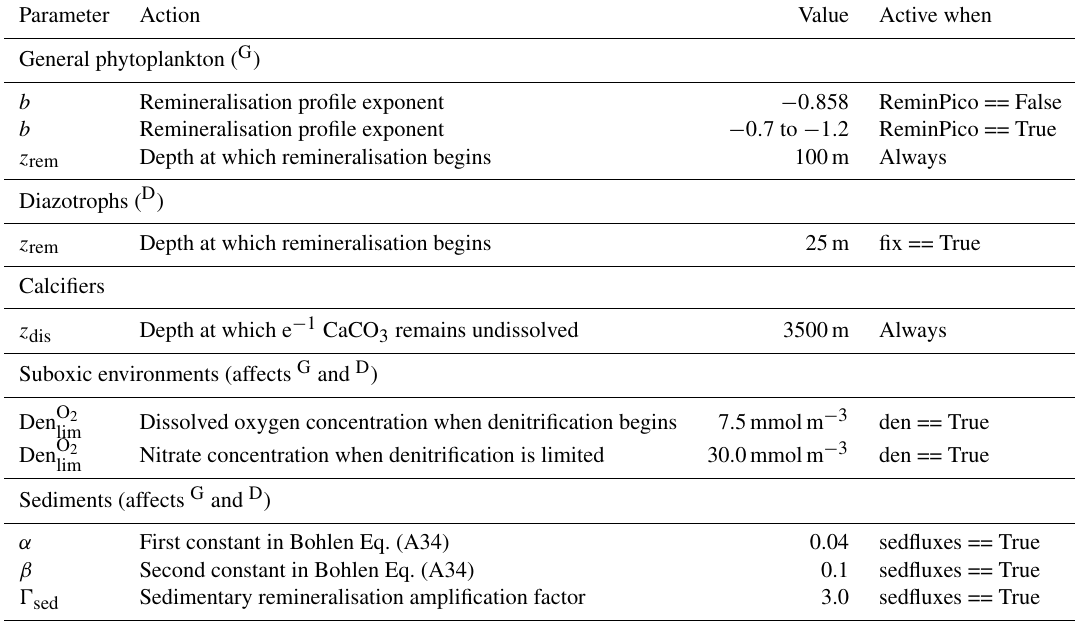
Table B2. Parameter values controlling remineralisation in the ecosystem component of the CSIRO Mk3L-COAL ocean model. Default settings: ReminPico == True , fix == True , den == True and sedfluxes == True .